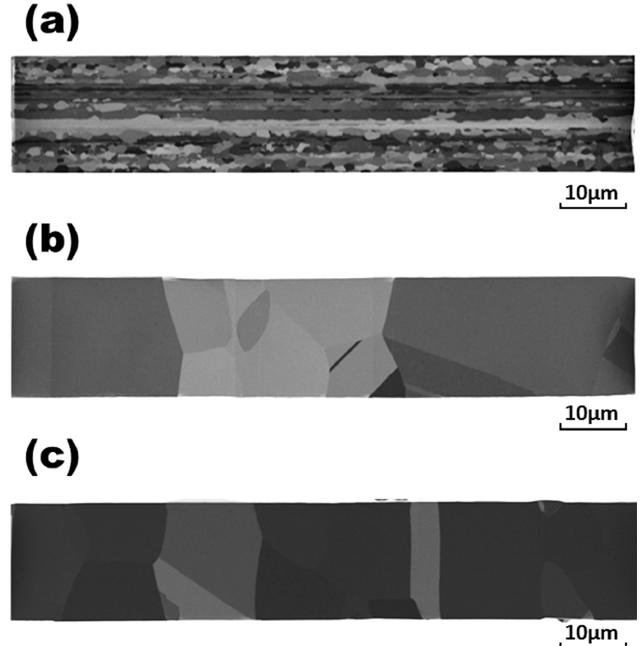
Figure 6. FIB image shows the grain structures in longitudinal cross ‐ sections of the pure Au wire after current stressing at 1.23 × 10 5 A/cm 2 for various times: ( a ) original; ( b ) 1 h; ( c ) 20 h.